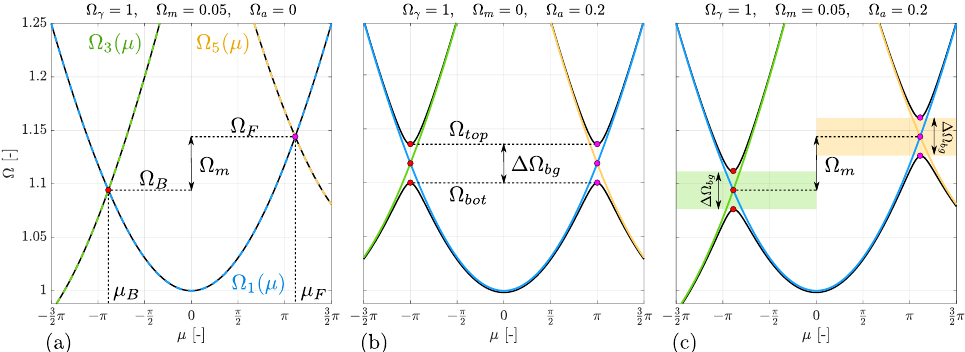
Figure 3. Dispersion relations for a rod on elastic suspensions with space–time modulation. Nu- merical results (black lines) are compared to the analytic results (colored lines), and key properties are shown on the dispersion diagrams for completeness. ( a ) Case with no amplitude modulation ( γ m = 0); ( b ) with constant properties in time ( ω m = 0); ( c ) with both modulations